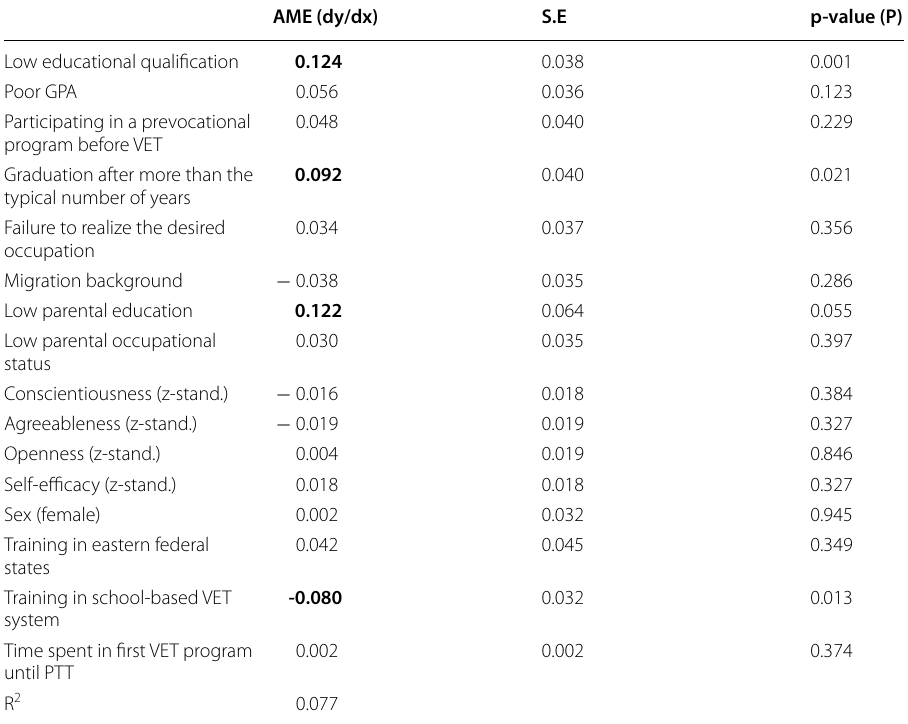
Dependent variable: entry in risk clusters (Cluster 5 to 7); reference group: re‑entry in institutionalized education (Cluster 1 to 4); n 4892; significance levels refer to AME coefficients; effects with p =